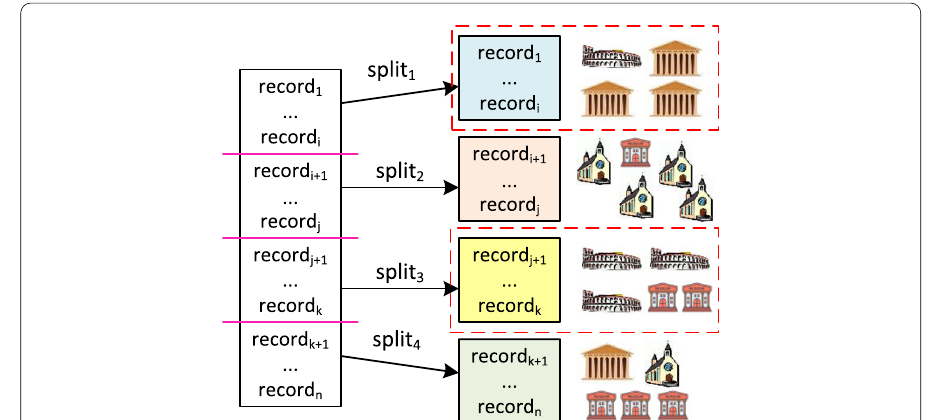
Fig. 1 Example of the default partitioning performed by Hadoop-like